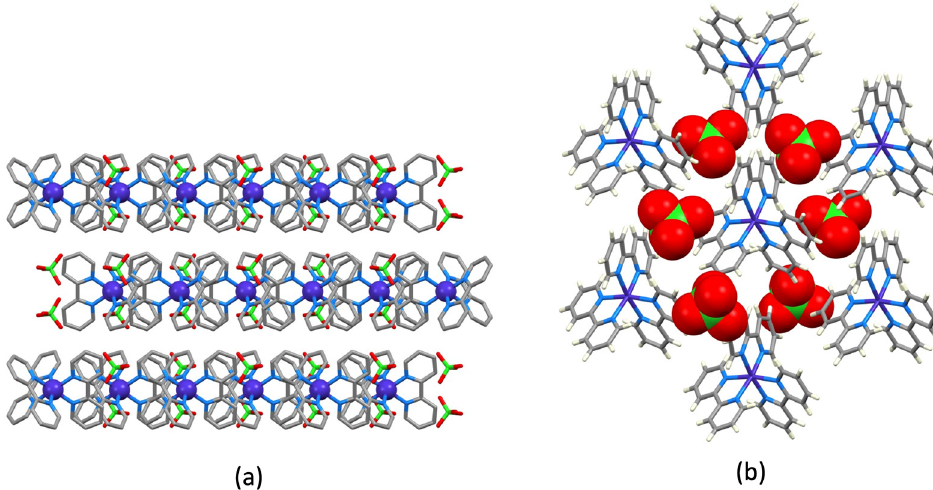
Figure 11. The structure of [Co(bpy) 3 ][ClO 4 ] 2 (refcode MEFCEG [76]). ( a ) Parts of three adjacent sheets viewed down the crystallographic a -axis; H atoms are omitted for clarity. ( b ) Part of one sheet viewed down the c -axis with anions in space-filling representation. Table 5. Structure Type IV motifs with [ClO 4 ] – anions.